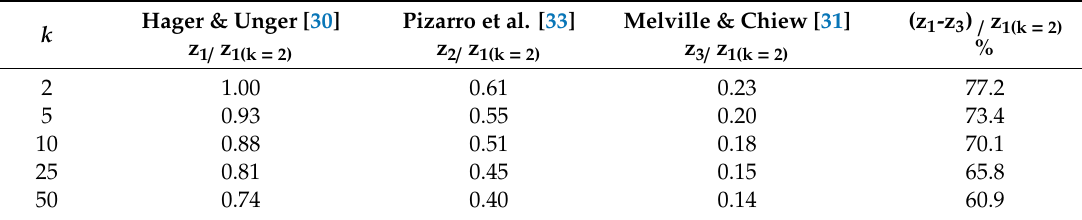
Table 3. Normalised scour depth estimates computed with the three different considered time-dependent scour models. Maximum relative differences between Hager and Unger [30] and Melville and Chiew [31] scour estimates for different values of k .